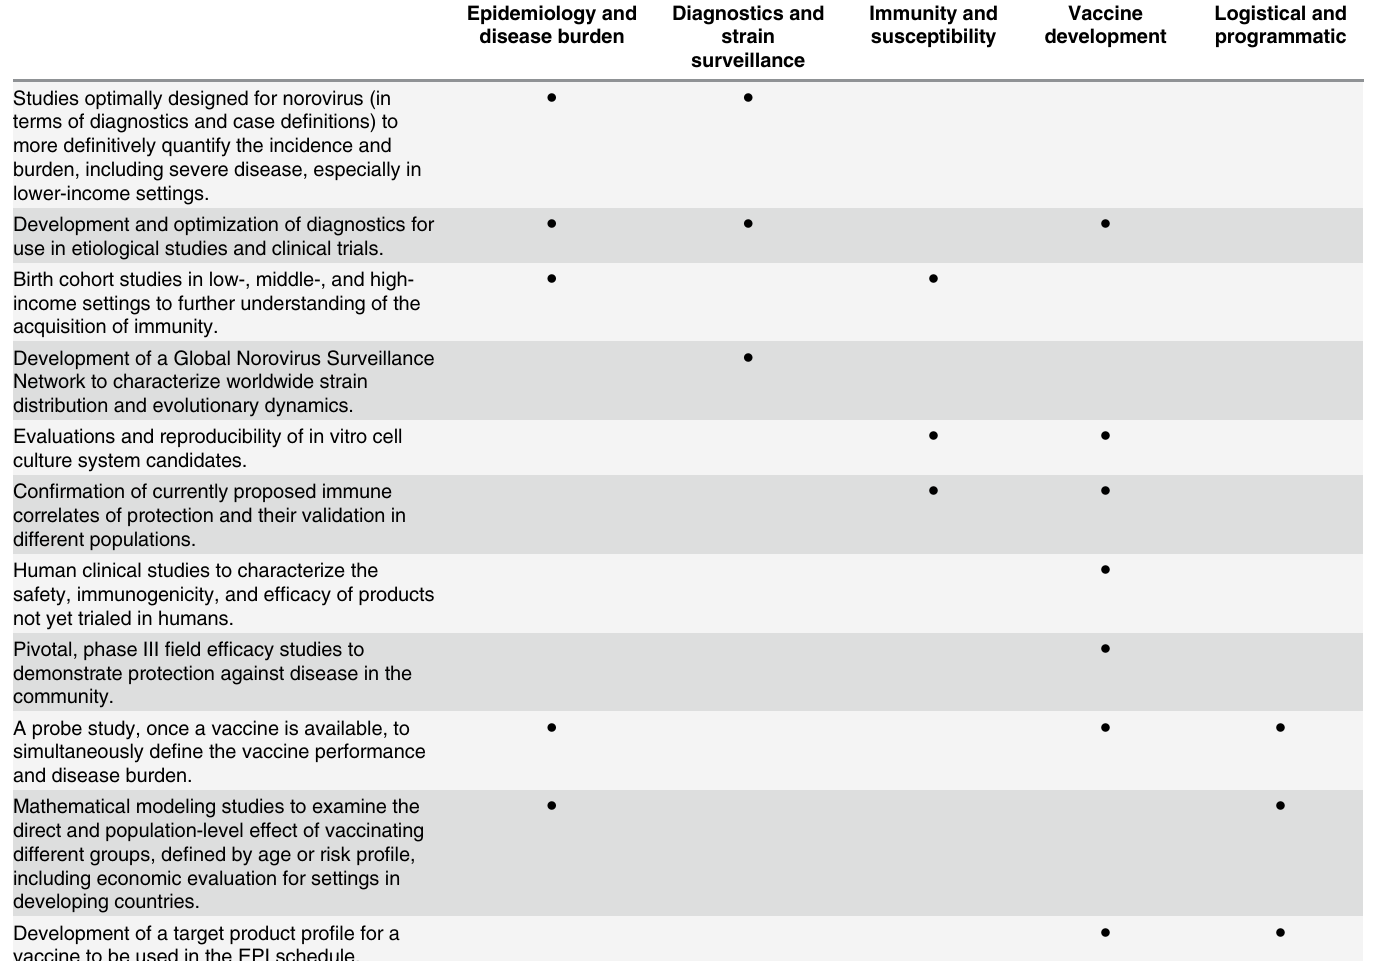
Table 3. Critical studies to be performed and questions to be answered to advance vaccine